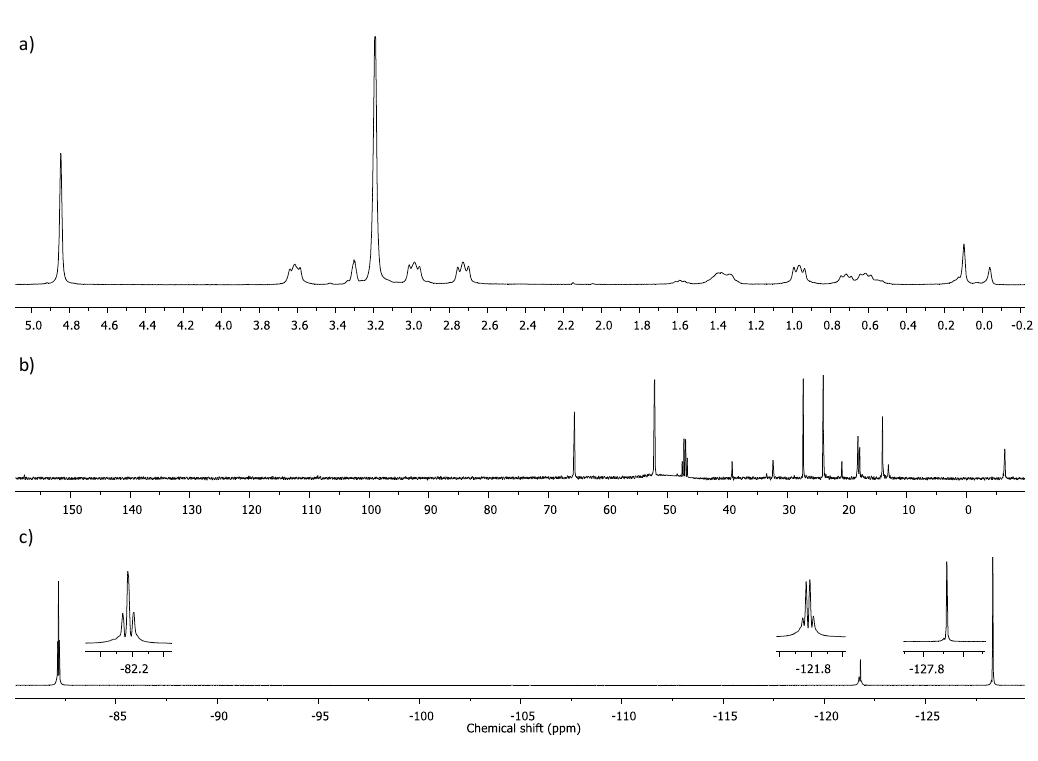
Figure 2. ( a ) 1 H-NMR; ( b ) 13 C{ 1 H}-NMR and ( c ) 19 F-NMR spectra of compound 9 in CD 3 OD.